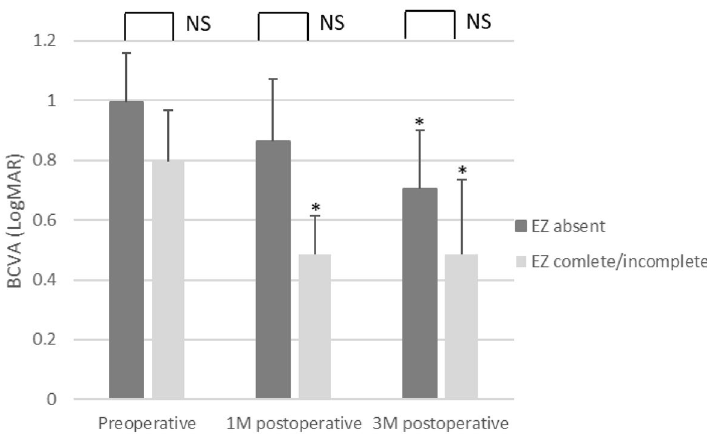
Figure 3. Comparison of postoperative BCVA classified by preoperative EZ status. *P <